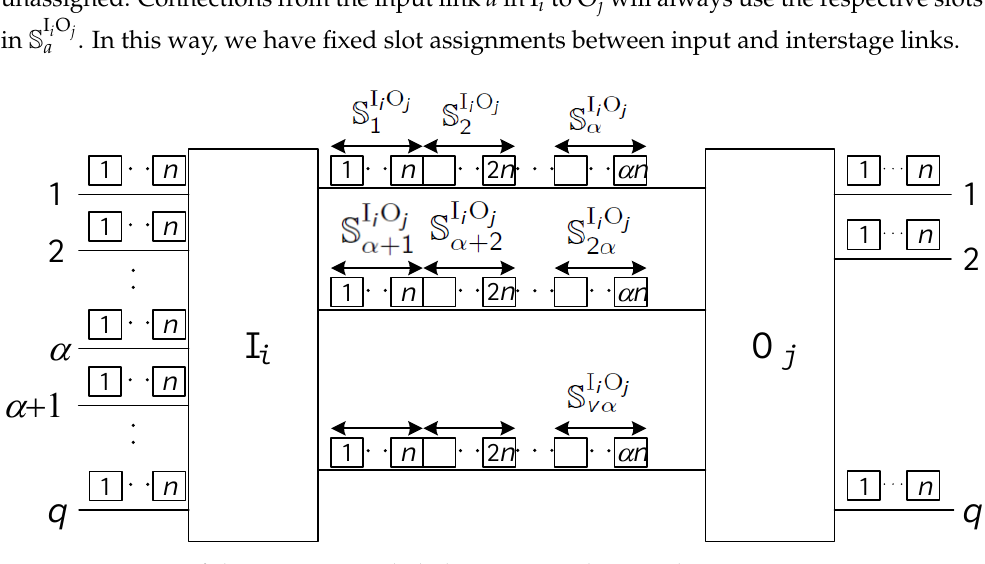
Figure 3. Division of slots in interstage links between switches I i and O j into